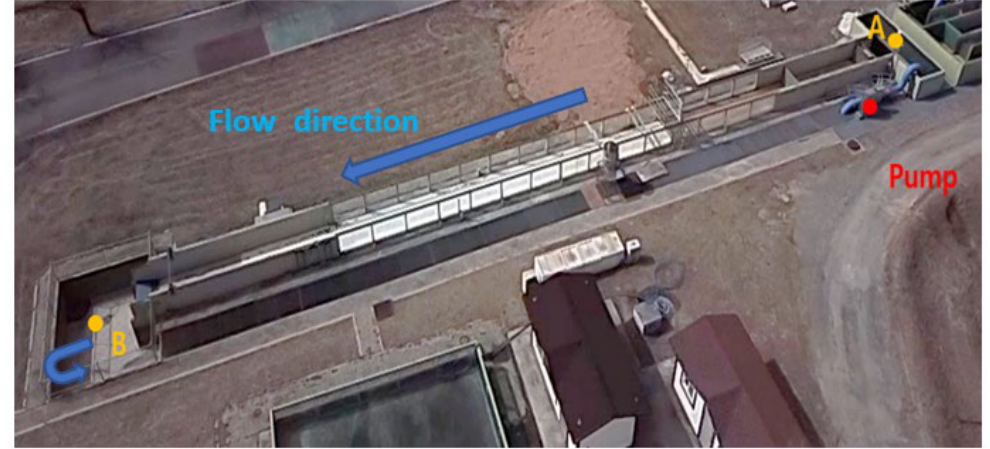
Figure 1. Experiment site: 50 m long circulating channel at the Andong River Experiment Center (REC).